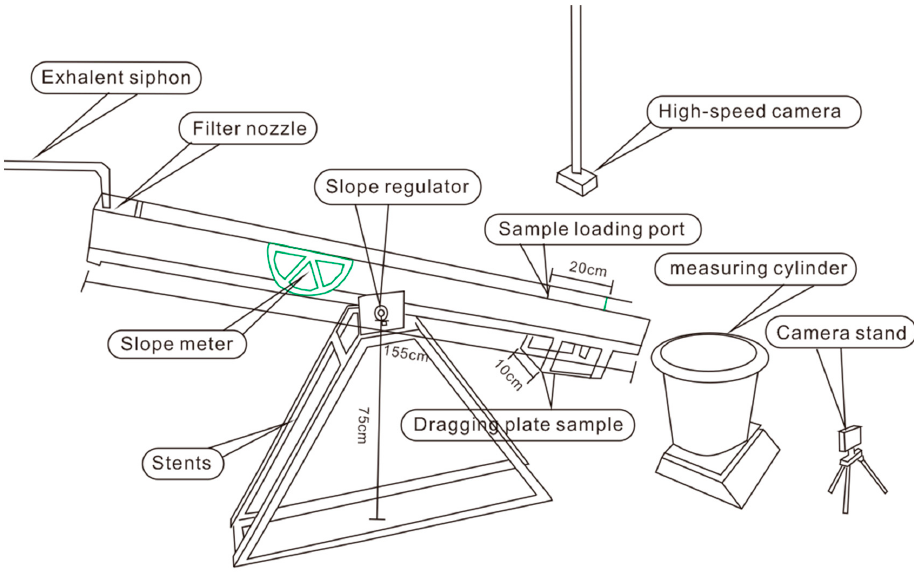
Figure 2. Apparatus used in the test.